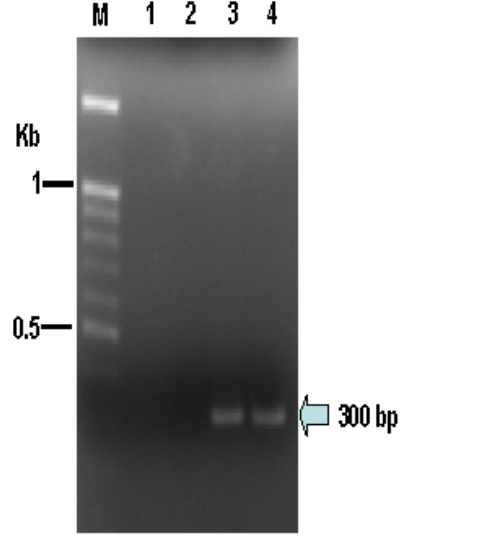
Figure 6. Reverse transcription PCR targeting the bandit transposon. Transcripts encoding the transposase of bandit were amplified by PCR from cDNA of the adult mixed sex of A. caninum . Products of the expected size, 300 bp are indicated with the arrow; lane 1, negative control where reverse transcriptase was omitted from the reaction; lane 2, empty lane; lane 3, plasmid DNA of clone H118 (positive control); lane 4, cDNA of mixed sex adult hookworms. Molecular size standards (lane M) are shown at the left.